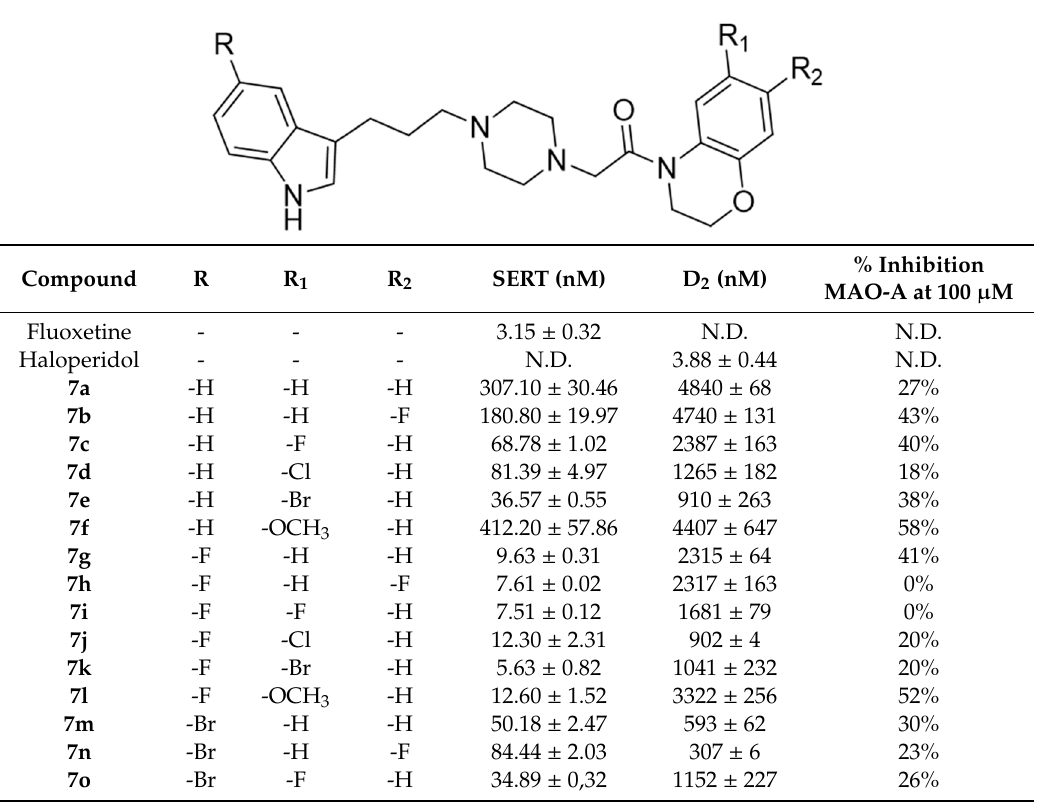
Table 1. Affinities, measured as K i values at the serotonin transporter (SERT), D 2 receptor, and percent of monoamine oxidase-A (MAO-A) inhibition (at 100 µM) of indolepiperazinyl benzoxazine derivatives (Series I).